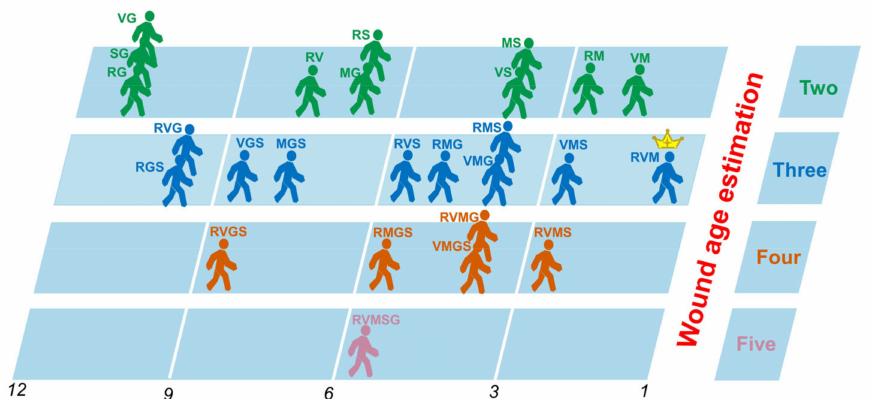
Figure 5. Overall performance ranking of the 26 stacked ensemble models based on the Borda count.